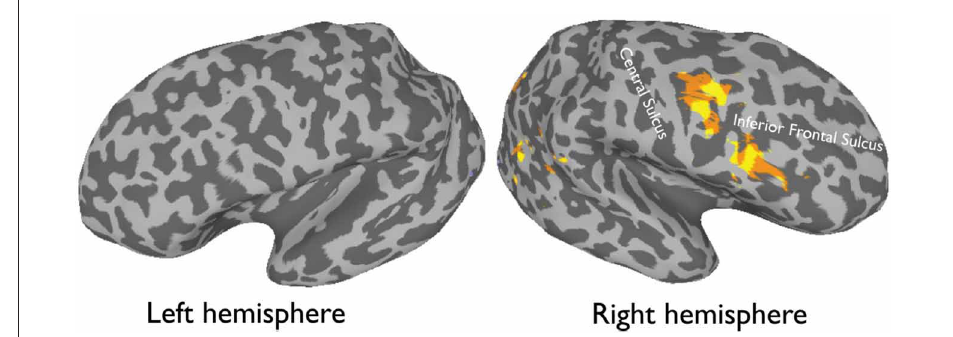
FIGURE 1 | An average activation map of 12 participants, 1-back task (faces > objects, random effect p < 0 . 001, t = 4 . 20) overlaid onto an